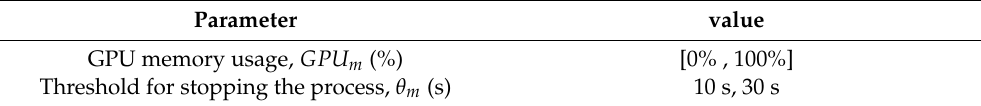
Table 4. Configuration and hyperparameter of the 2nd edge